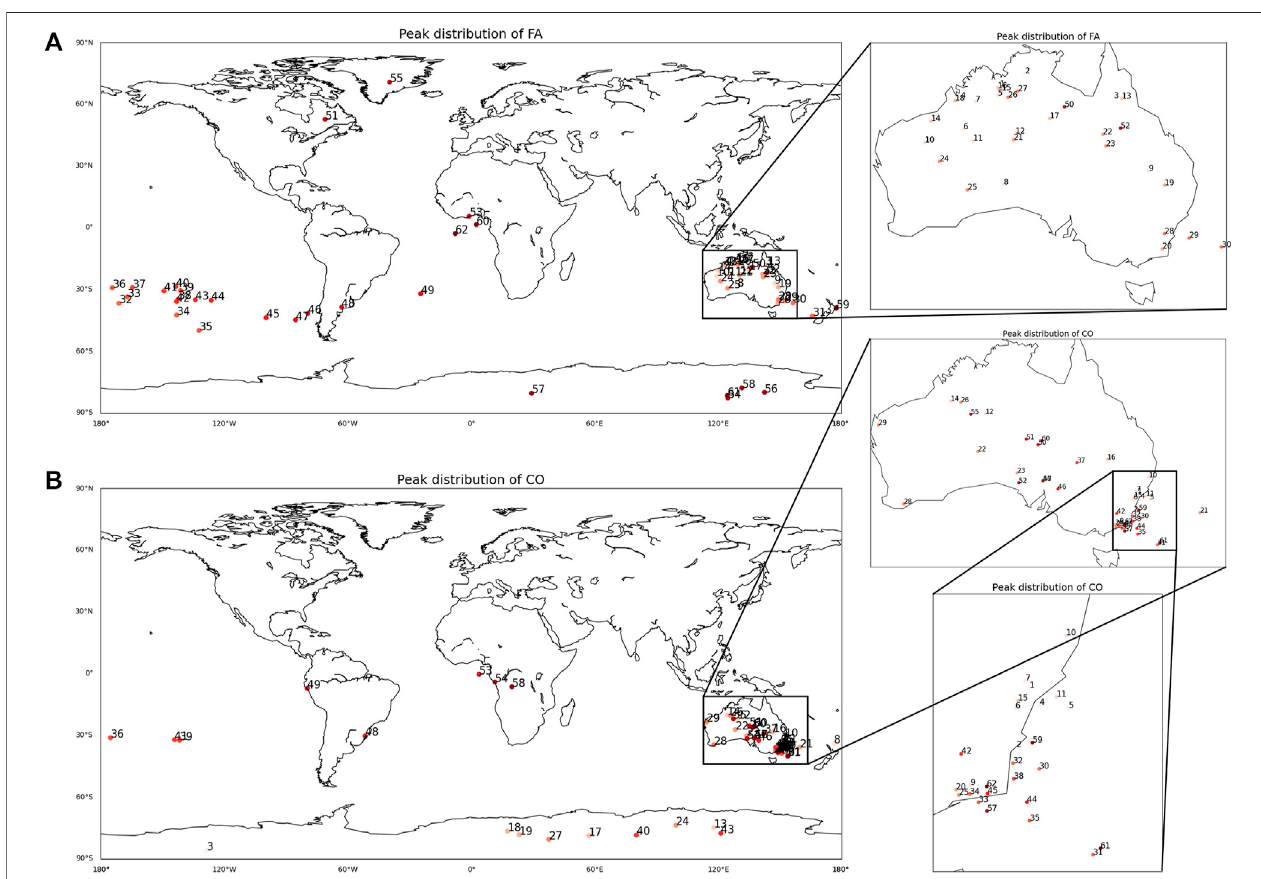
FIGURE 4 | Peak TC distribution of (A) FA and (B) CO, where the number represents the number of days after December 1, 2019.